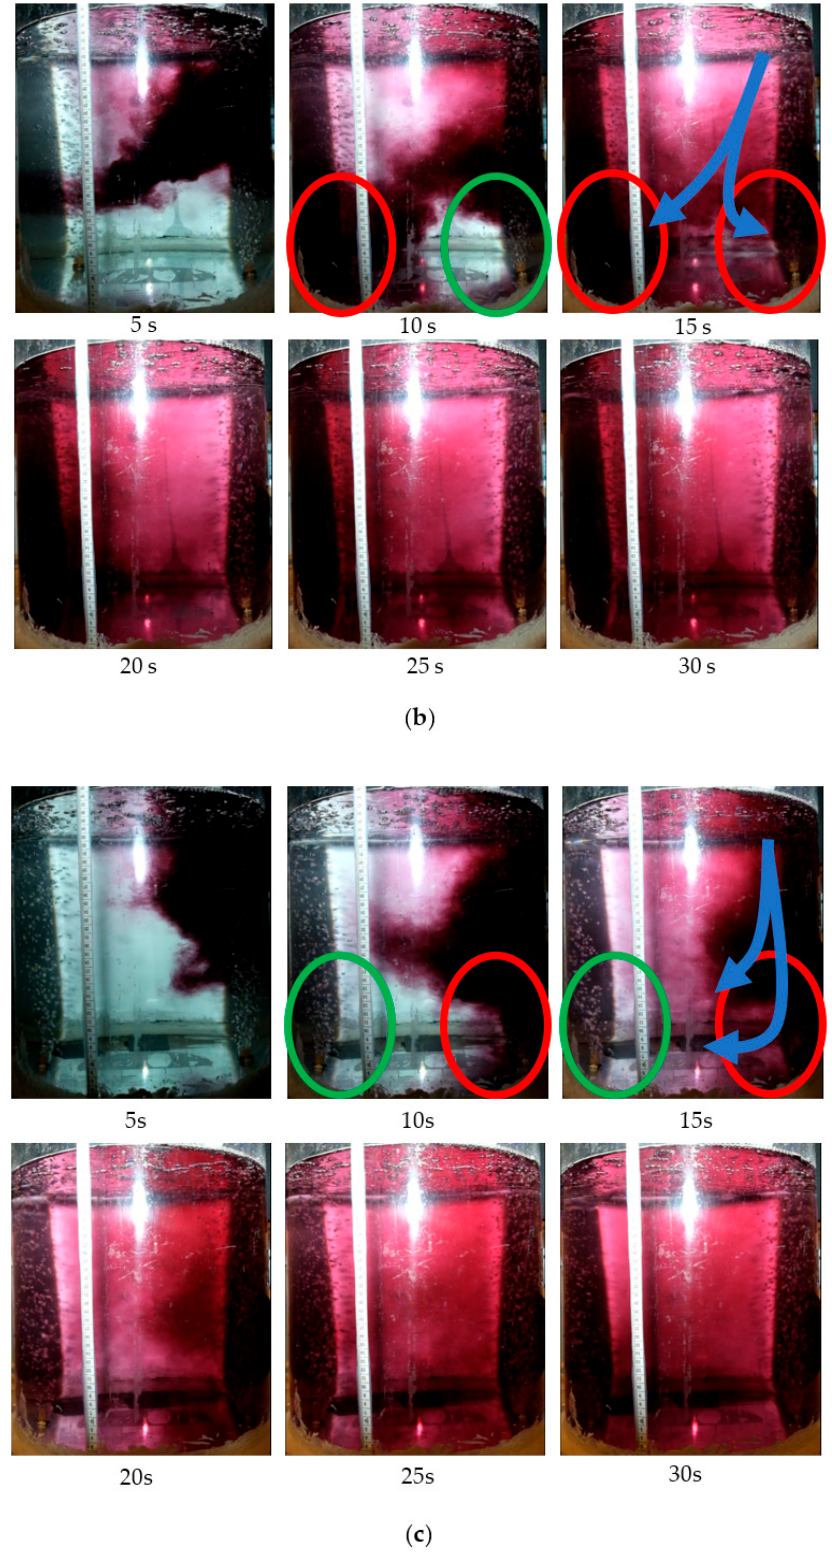
Figure 8. Color dye path for a 1.63 L·min − 1 flow rate when using various radial-plug angles: ( a ) 90°; ( b ) 135°; and ( c ) 180°.